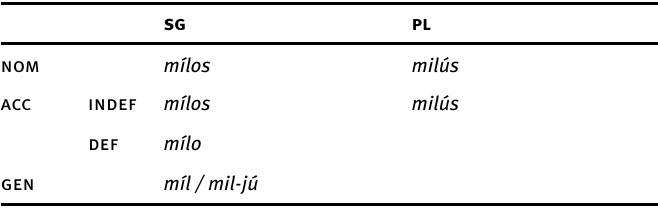
Table 11. Inanimate declension in North